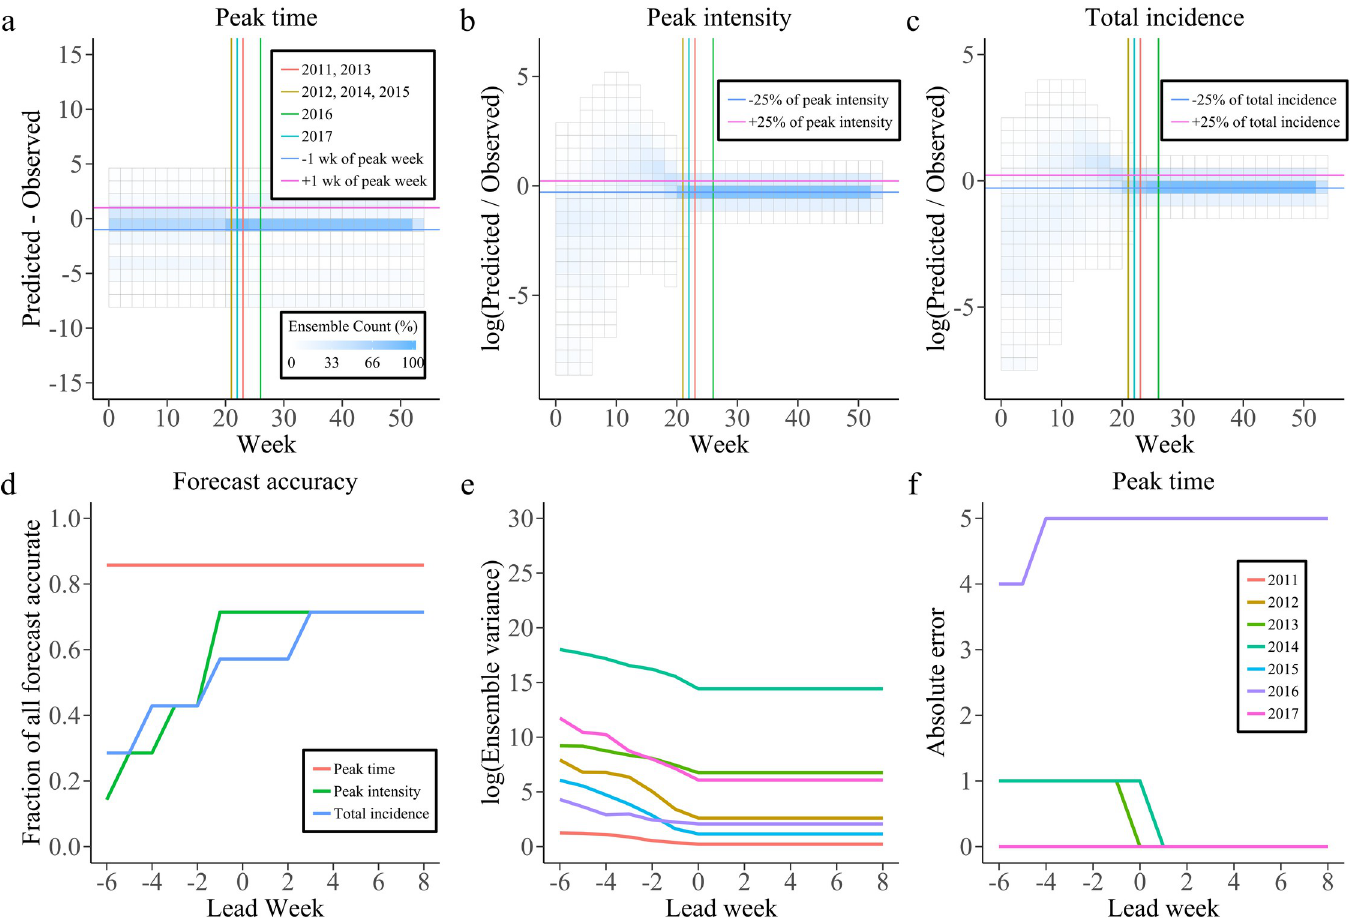
Fig 4. Results for 2011–2017 retrospective forecasts. a-c Distributions of the peak time (peak intensity and total incidence) distance from the predicted values to the observed target on each predicted week. The peak time for different dengue season is distinguished with distinct color vertical lines. The horizontal lines are representing the +1 wk (+25%, pink) and the -1wk (-25%, blue) from the observed peak week (peak intensity or total human dengue cases). d The fraction of forecasts accurate as a function of lead week for the targets peak time (red), peak intensity (green) and total incidence (blue). A forecast can be considered as accurate when (1) peak time was within ± 1 week of the observed peak of weekly new infected dengue cases; (2) peak intensity was within ± 25% or ± 1 cases of the observed peak weekly new infected dengue cases; (3) total incidence was within ± 25% of the observed. e, f characteristics the ensemble variance ( e ) and absolute error ( f ) for those predictions of each pandemic seasons which distinguished with different